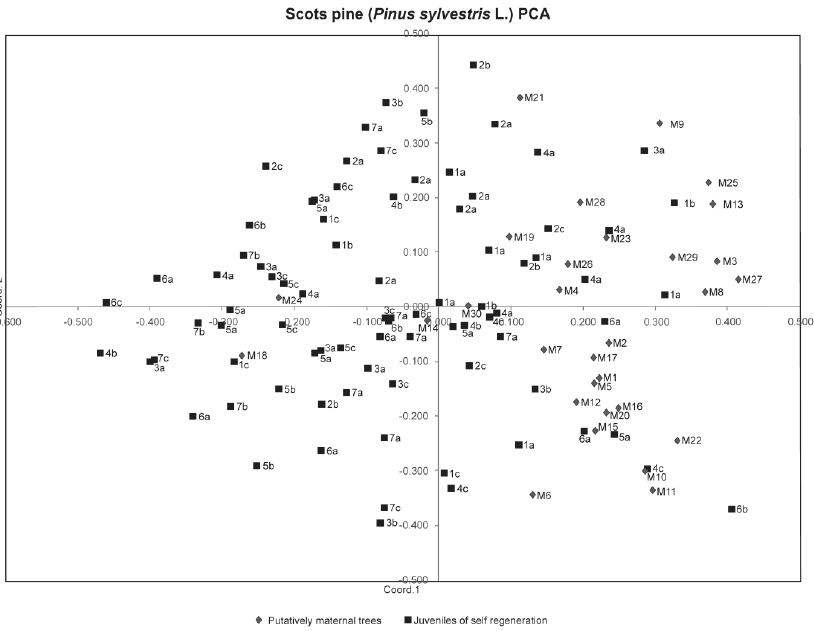
Figure 4. PCA diagram showing the distribution of Scots pine tree microsatellite multi-locus genotypes, based on data from eight genetic markers. 1a to 7a, 1b to 7b and 1c to 7c groups of three to six sampled self-regenerating Scots pine juveniles in each of the respectively numbered sampling plots (Figure 2); M1–M30, putatively maternal Scots pine trees from the surrounding stand (for tree distribution, see Figure 2).